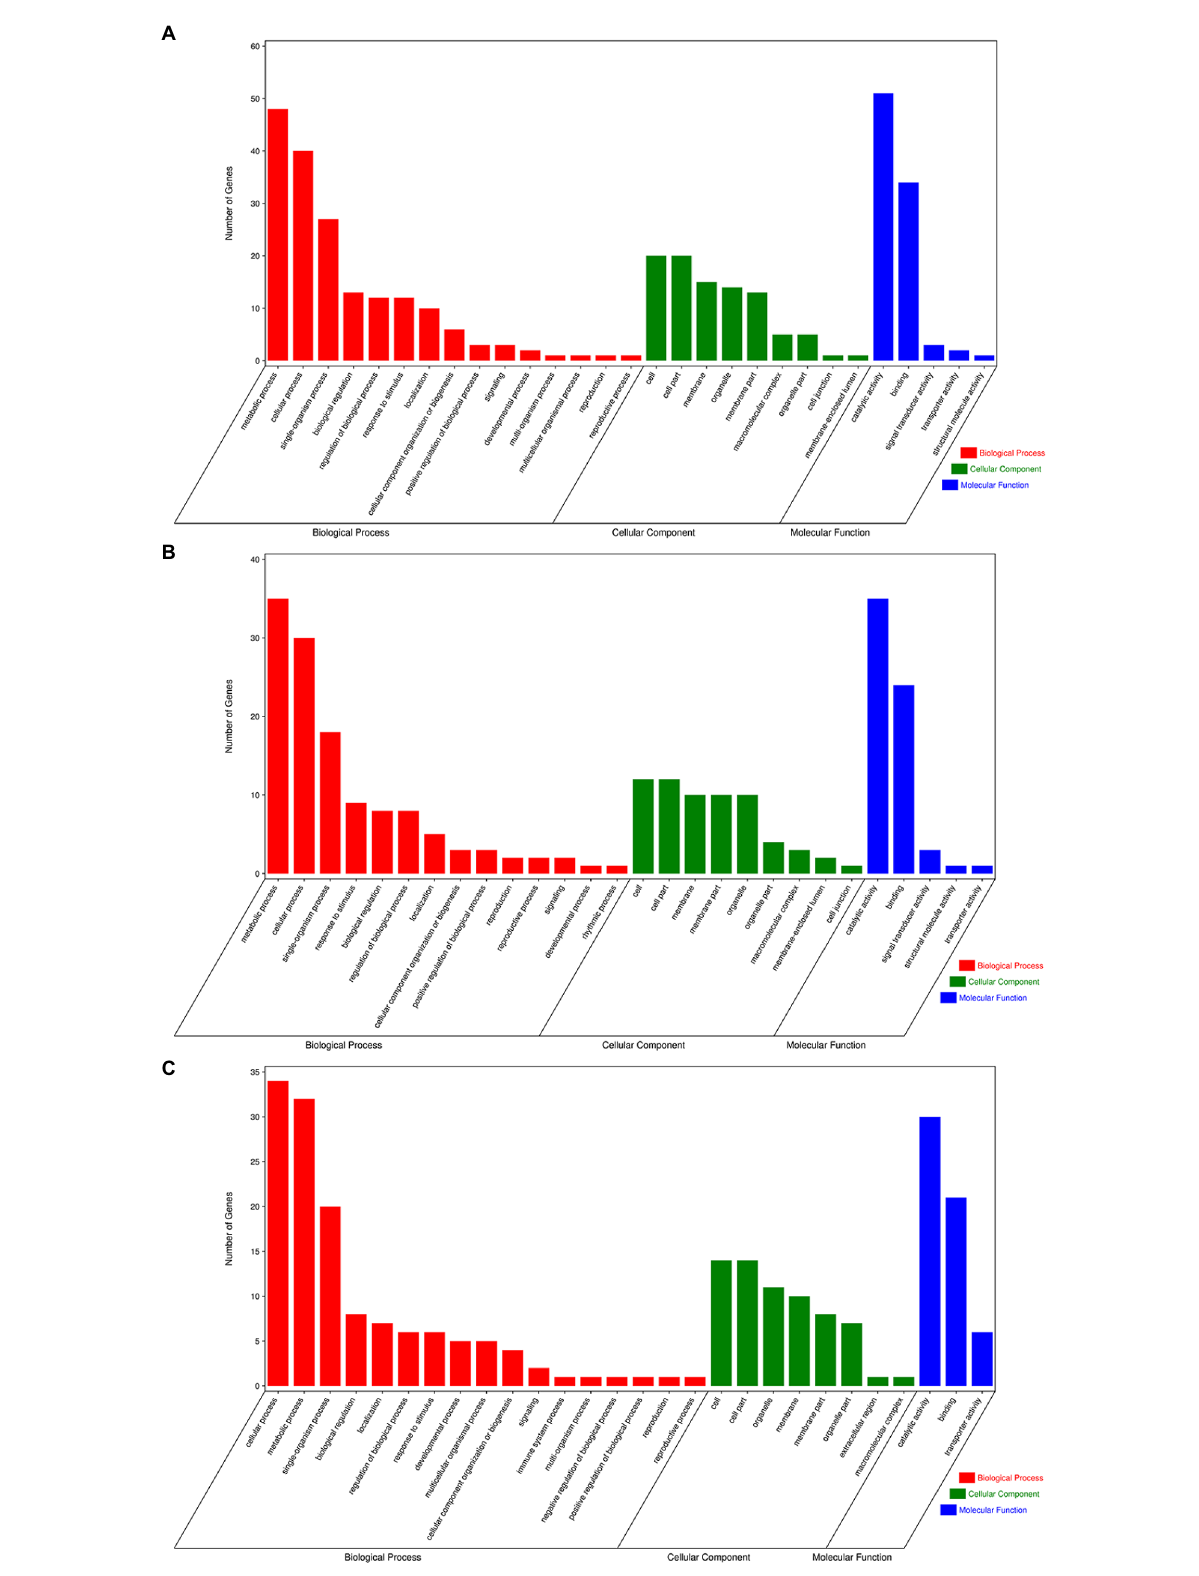
FIGURE 7 Gene ontology of the predicted targets for differentially expressed miRNAs. (A) GO terms for CK vs. UI, (B) BI vs. UI, and (C) CK vs.